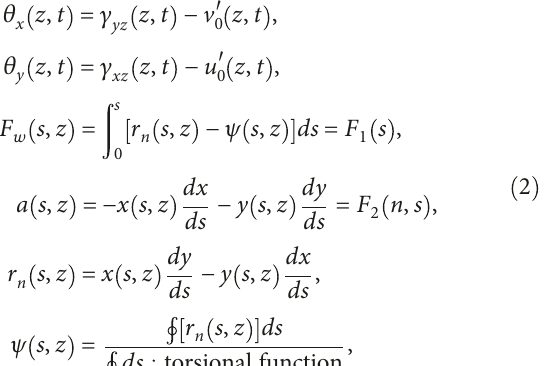
Figure 5: Noncorrected primary warping functions of Model A.